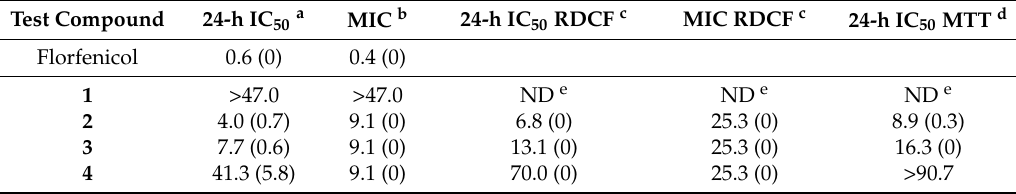
Figure 1. The chemical structures of (+)-ampelopsin ( 1 ), (+)-hopeaphenol ( 2 ), (+)-vitisin A ( 3 ) and (+)-vitisin B ( 4 ). Table 2. The bioassay evaluation of compounds isolated from the crude extract of the roots of V. rotundifolia against F. columnare .